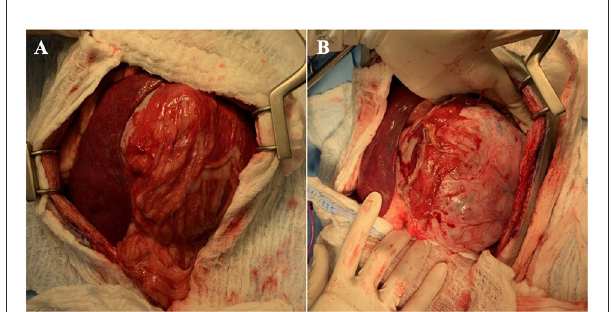
FIGURE2 (A) Initial abdominal explore findings with left renal mass surrounded by omentum (right) and spleen (left). (B) Left renal mass following dissection of omental